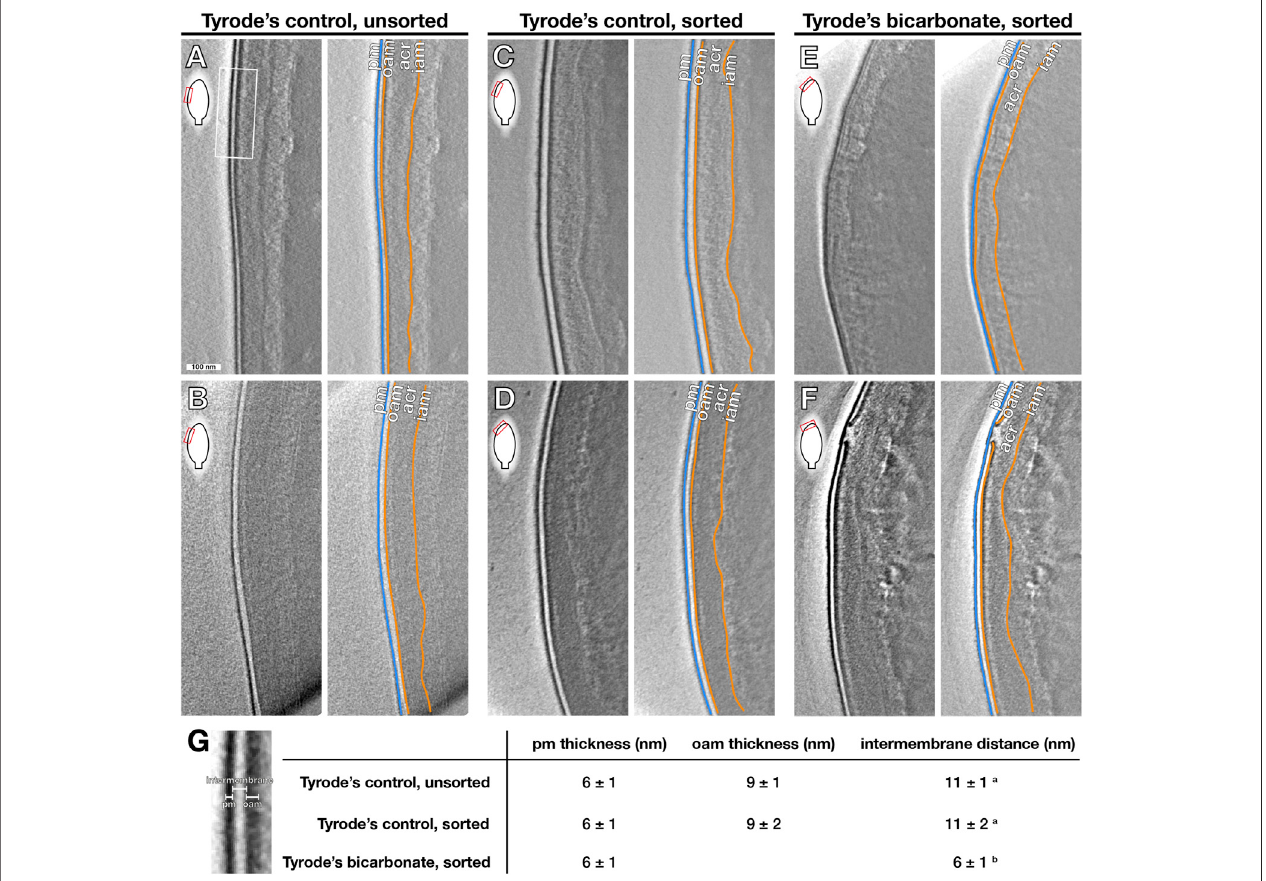
FIGURE 4 | Sperm membrane reorganization detected by Cryo-ET after incubation with bicarbonate. Spermatozoa were incubated either in the presence of 30 mM bicarbonate (Tyr Bic ) or its absence (Tyr Control ) for 60 min and then FACS-sorted to inspect membrane reorganization using cryo-electron tomography (cryo-ET). To mark structures identi fi ed by cryo-ET, the membranes are colour coded to indicate the plasma membrane (PM) (blue), outer acrosomal membrane (OAM), and inner acrosomal membrane (IAM) (orange) that surround the acrosomal content. Red boxes indicate the approximate region of the sperm head featured in the frames. Unsortedspermatozoa in Tyr Control typically demonstrated anintact PM and OAM thatwere smooth and ran parallel toeach otheralong thesperm head (A,B) . Thiswas also observed in a majority of FACS-sorted viable, “ low fl uidity ” cells in TyrControl (C,D) ( n (cid:2) 3 stallions). However, sorted viable, “ high fl uidity ” sperm cells incubated in Tyr Bic mostlyshowedevidenceofmembraneremodellinganddestabilization,includingcloserapproximationofthePMandOAM (E) inparticularat (F) pointsofapparent rupture of the OAM (F) , leading to a decrease in apparent intermembrane distance (G) ( n (cid:2) 3 stallions).